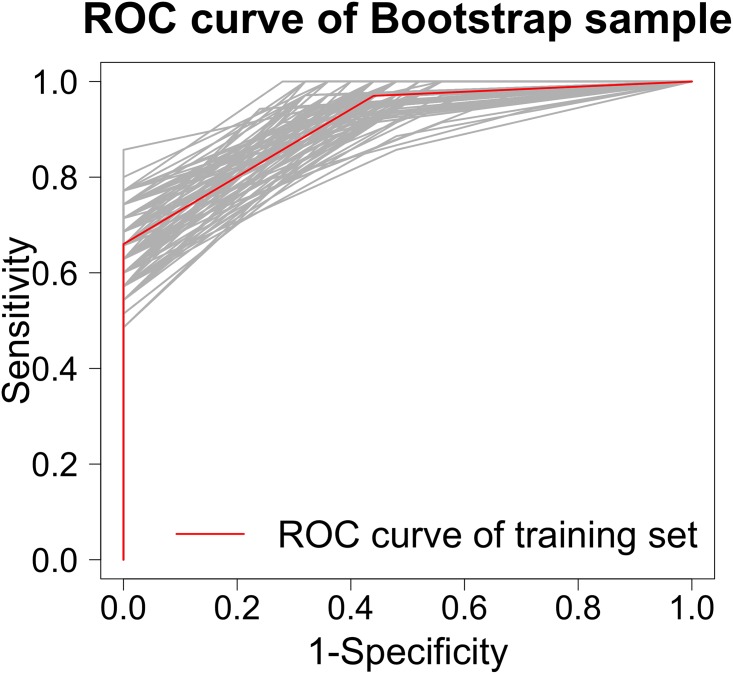
Bootstrapped distribution of estimated receiver operating characteristic (ROC) curve shown in Fig 2 (which is superimposed in red).100 bootstrap samples were considered.